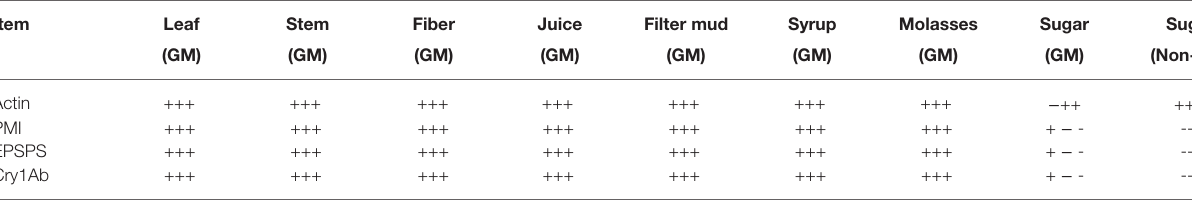
TABLE 4 | PCR analysis of all DNA samples.